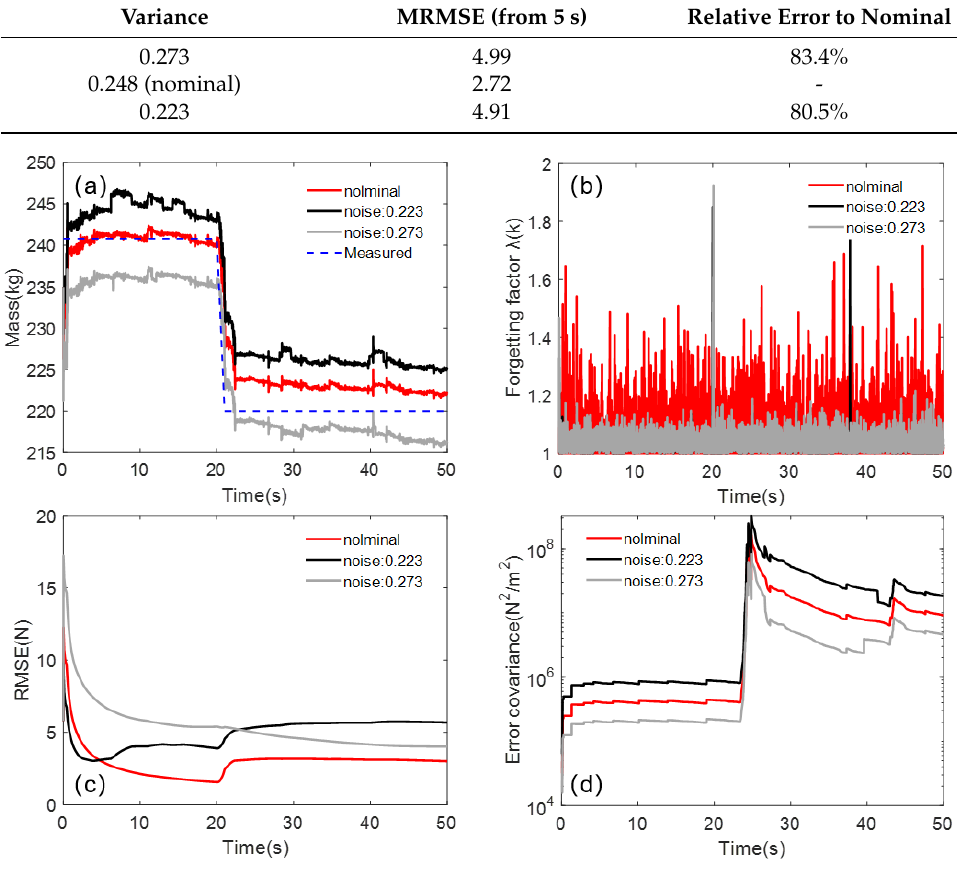
Figure 10. Simulation result of vehicle mass estimation with respect to different noise ( a ) estimated vehicle mass according to several noises, ( b ) time evolution of the forgetting factor, ( c ) RMSE, and ( d ) convergence history of error covariance.